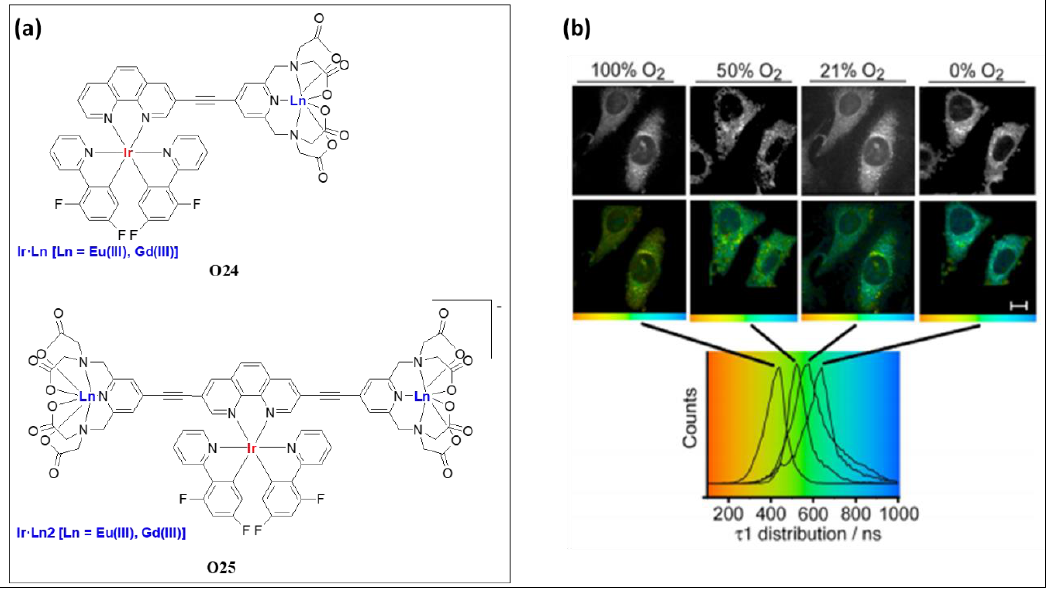
Figure 15. ( a ) Ir(III)/Ln(III) di- and trinuclear complexes ( O24 and O25 ). ( b ) Two-photon PLIM imaging of O24 (Ln = Gd) stained Hela cells under different concentrations of oxygen. Reproduced with permission from ref. [76].